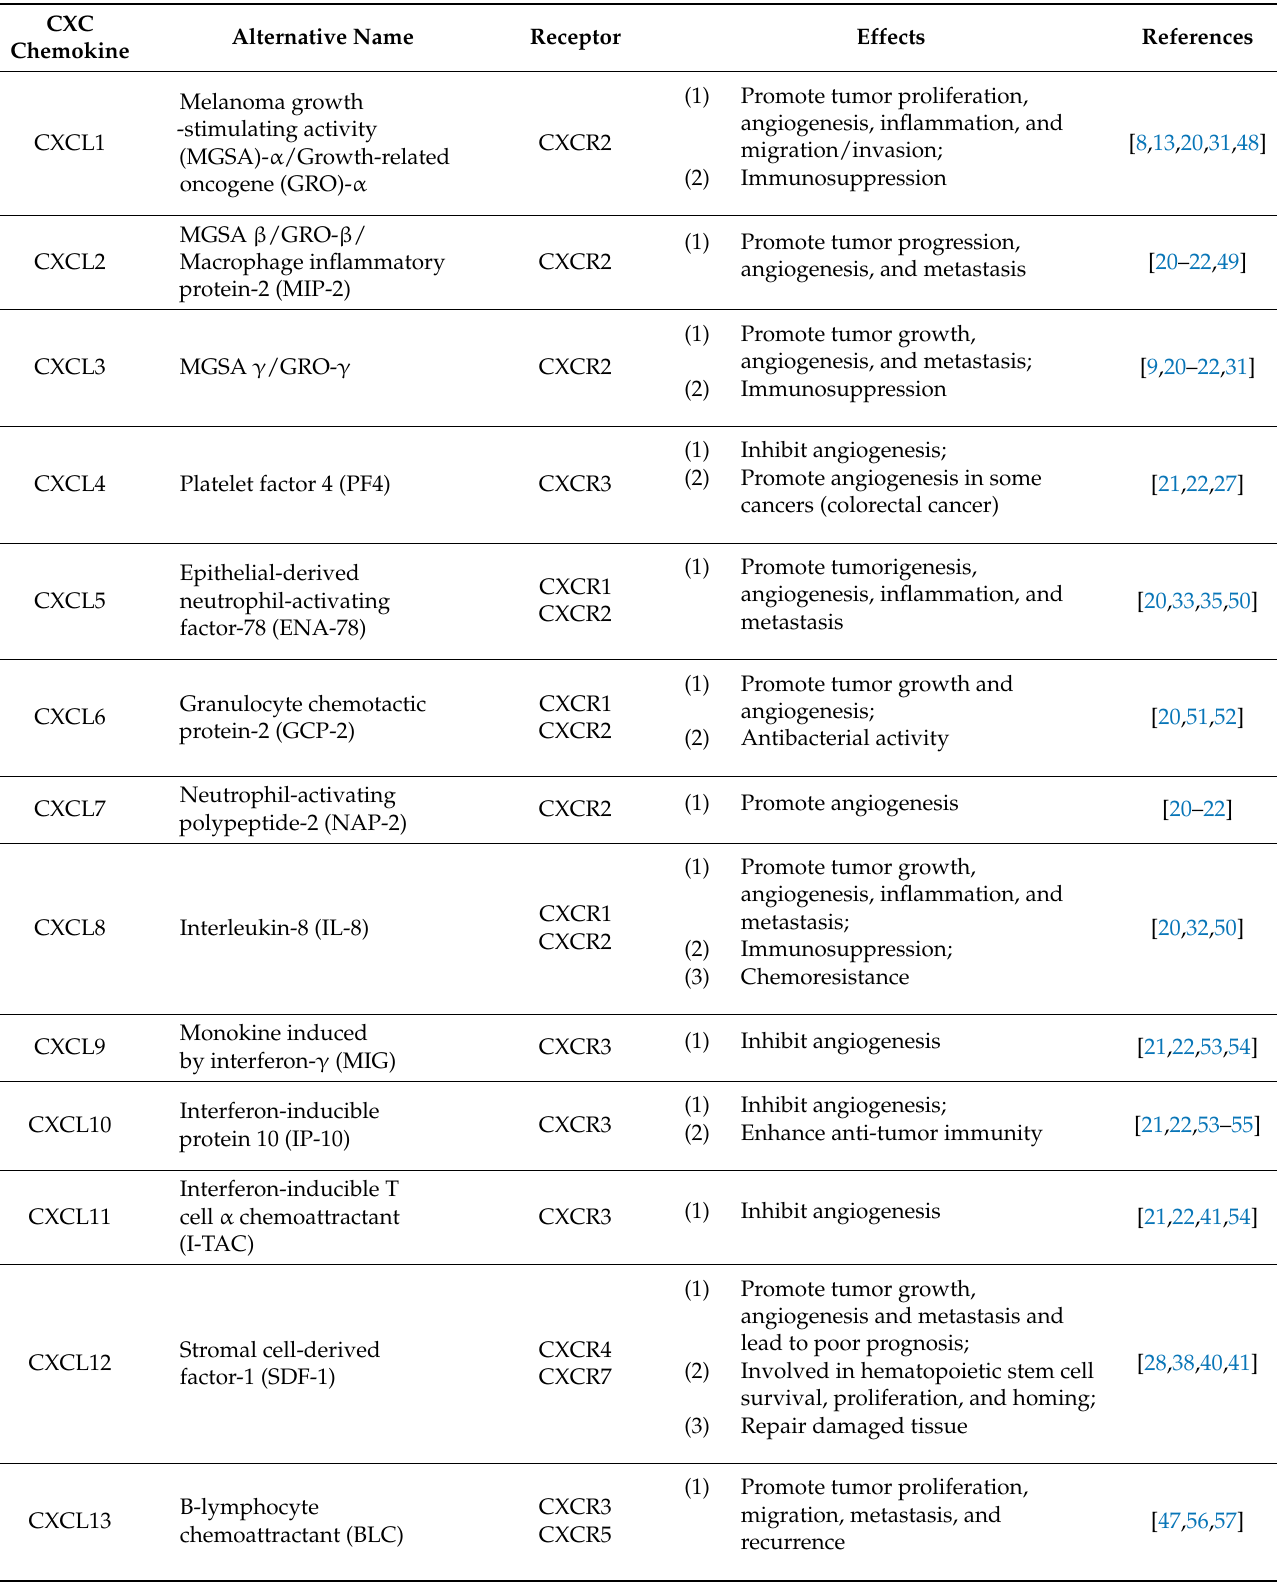
Table 1. CXC chemokine effects in physiological and pathological